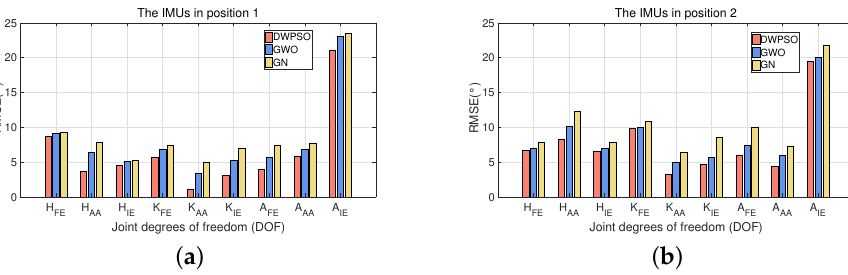
Figure 9. The RMSE ( ◦ ) comparison of three algorithms when IMUs on subject 1 were bound in two positions. ( a ) The IMUs in position 1; ( b ) the IMUs in position 2. The IMUs in position 1